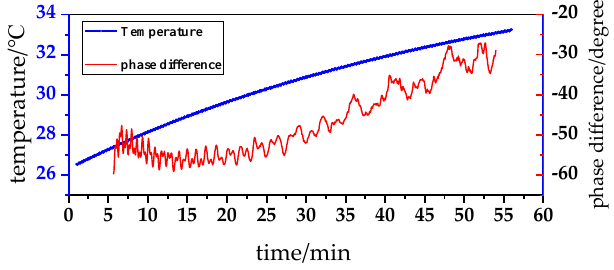
Figure 2. Thermally induced phase delay of round-trip polarization light in the system.